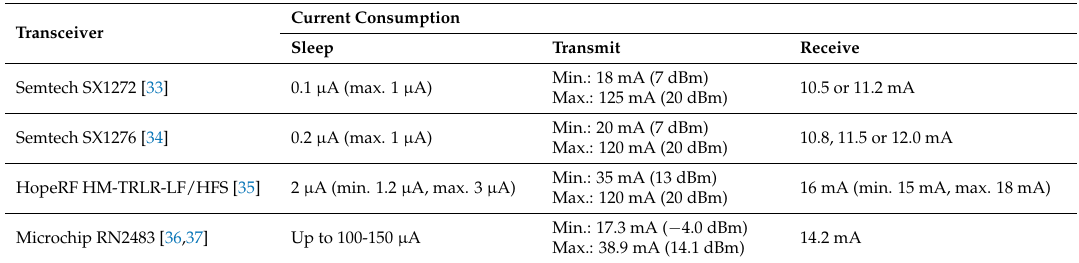
Table 2. Main current consumption details on LoRa/LoRaWAN transceivers used by devices in Table 1.